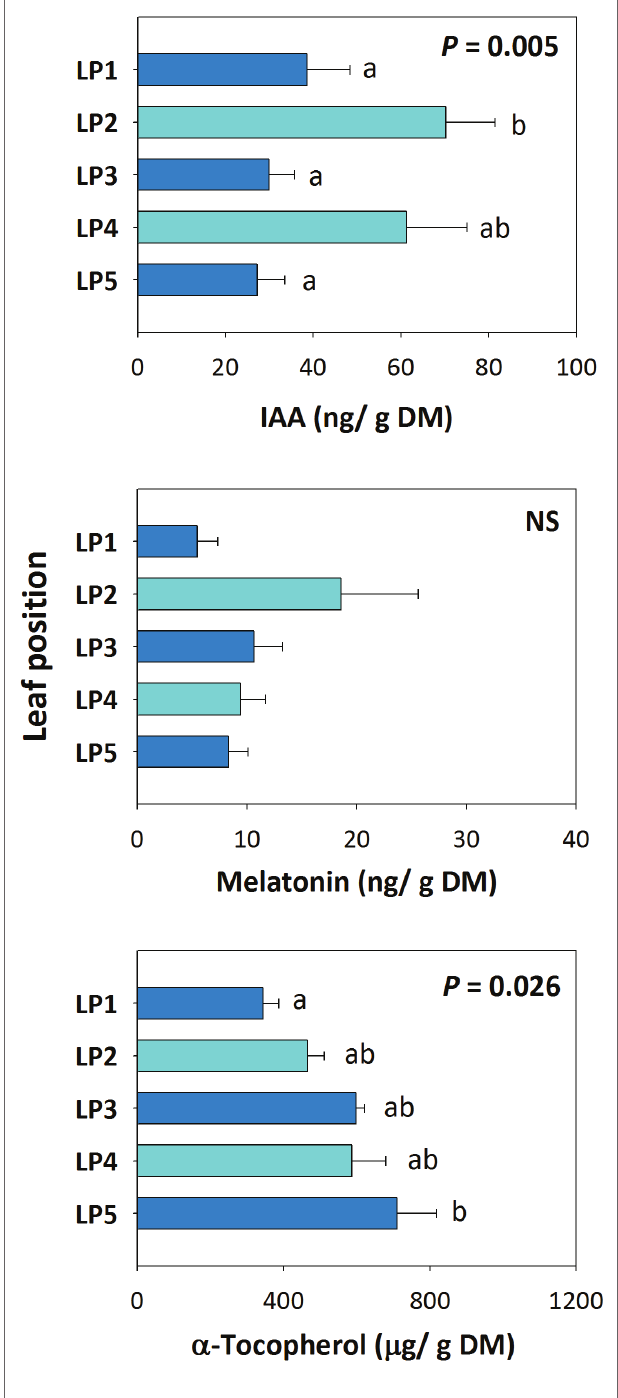
FIGURE 4 | Positional effects in endogenous melatonin contents in the Mediterranean shrub, C. albidus . A comparison between melatonin contents relative to those of the biosynthesis-related phytohormone auxin and the well-known chloroplastic antioxidant α -tocopherol in plants growing at the experimental garden of the University of Barcelona during January at midday is shown. Data represent the mean ± SE of n = 6 individuals. Significant differences in “Leaf position” were tested by conditional Fisher tests ( p ≤ 0.05), and different letters indicate significant differences in Tukey’s HSD multiple comparison test ( p ≤ 0.05). NS, not significant; DM, dry